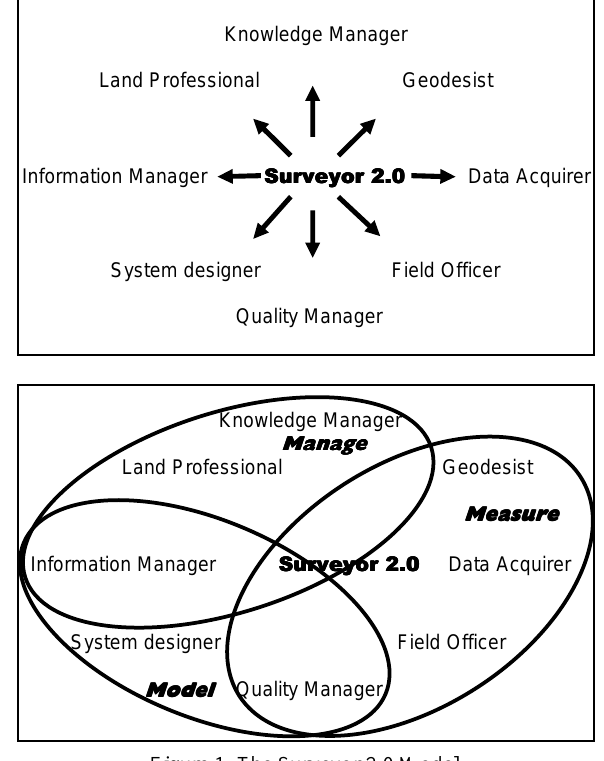
Figure 1. The Surveyor 2.0 Model, adapted from G. Schennach et al. (2012)